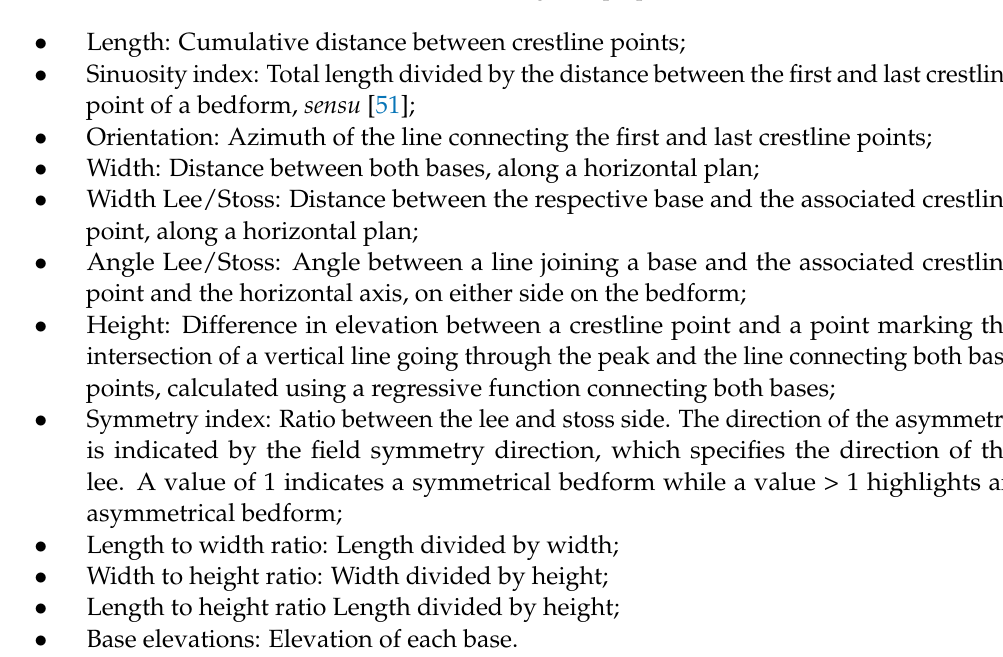
Figure 8. Illustration of the metrics calculated along each perpendicular transect.